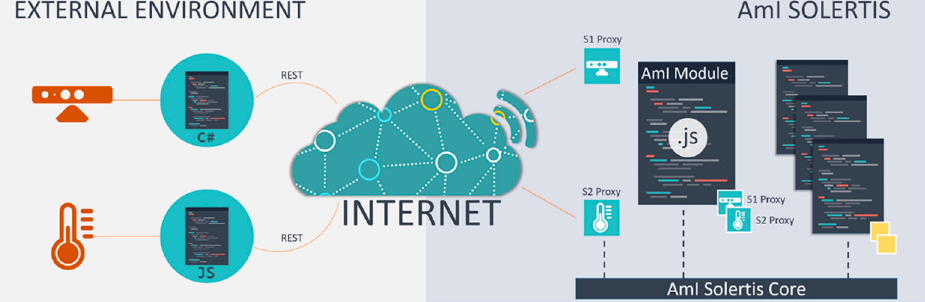
Figure 1. The AmI-Solertis Hybrid Communication Protocol.